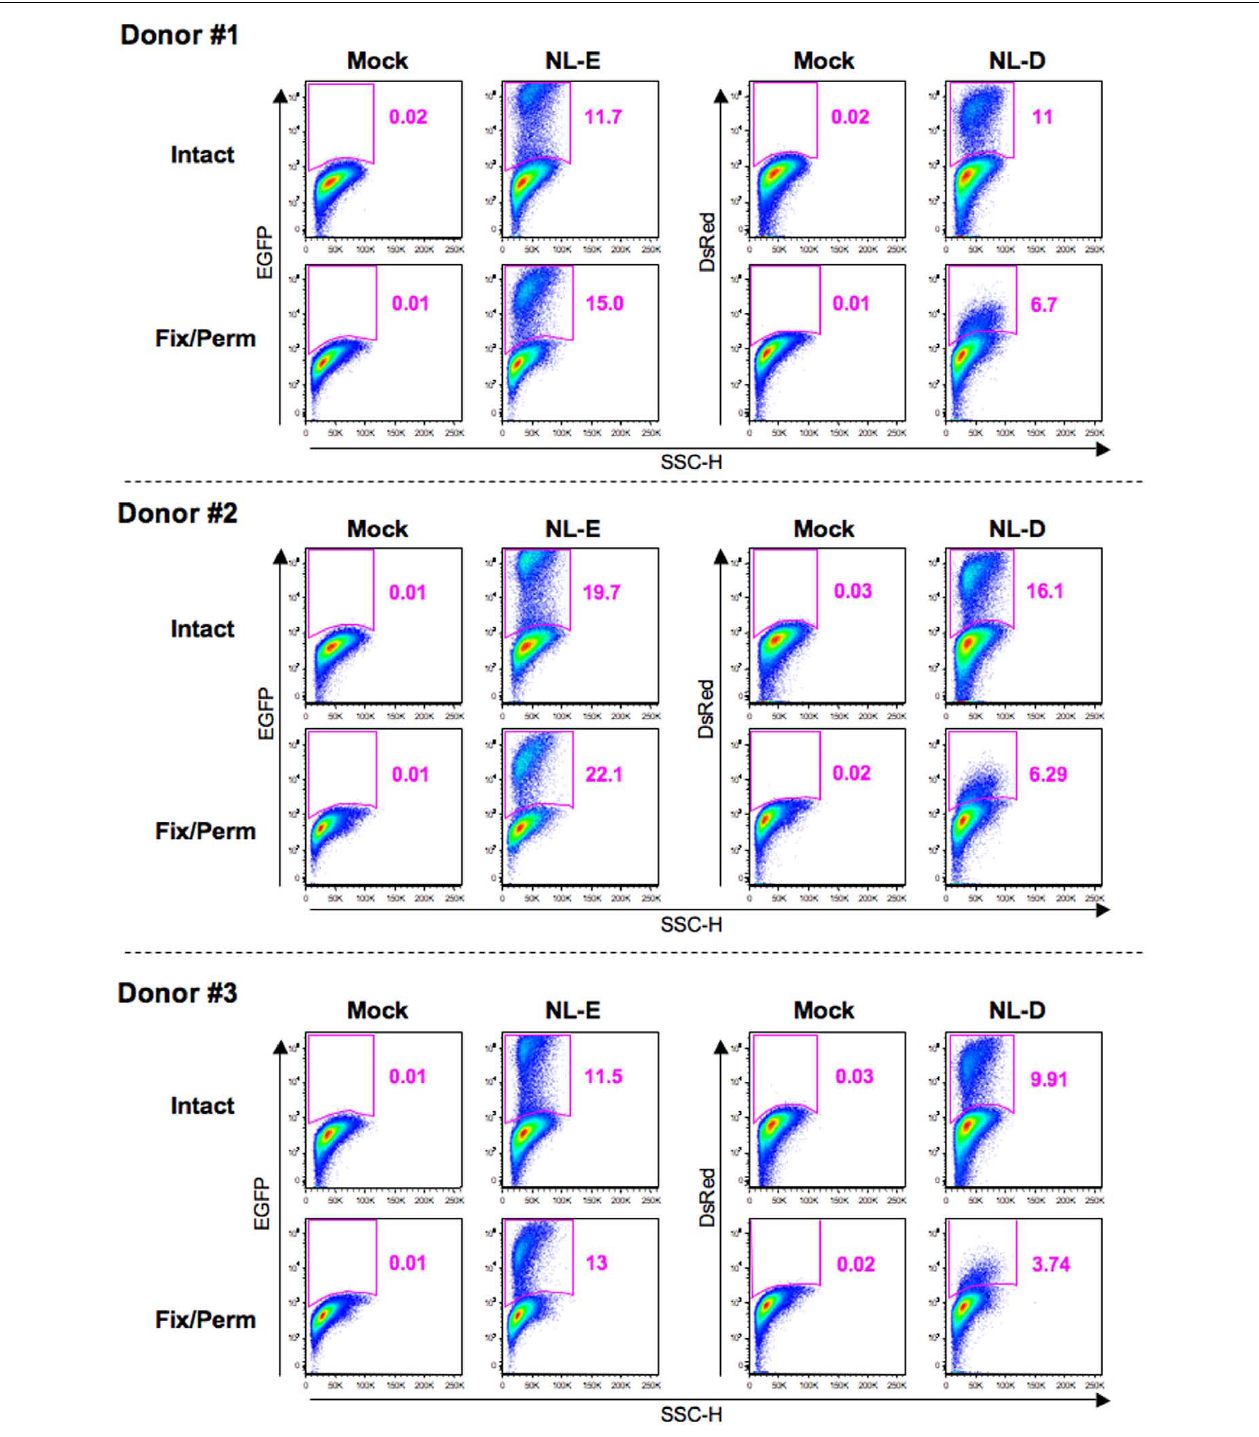
FIGURE 3 | Influence of fixation/permeabilization treatment on HIV-1 fluorescent reporter signals. Pseudo-color plot profiles for the Dead − /CD3 + /CD8 − -gated cell fractions from the mock, HIV-1 NL-E infection